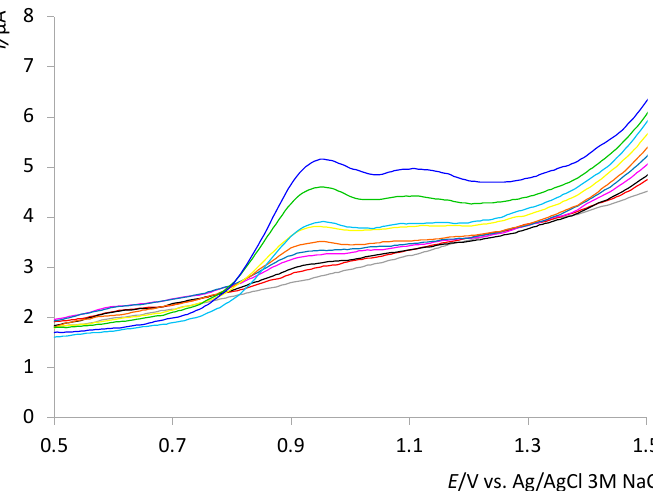
Figure 9. DPV of AH-7921 in ethanol/0.1 M lithium perchlorate and 0.10 M 2,6-lutidine; concentration range: from 5 µg·mL − 1 to 150 µg·mL − 1 . Potentials are referred to Ag/AgCl, 3 M NaCl. Scan speed: 50 mV·s − 1 . Working electrode: glassy carbon, 2 mm diameter.